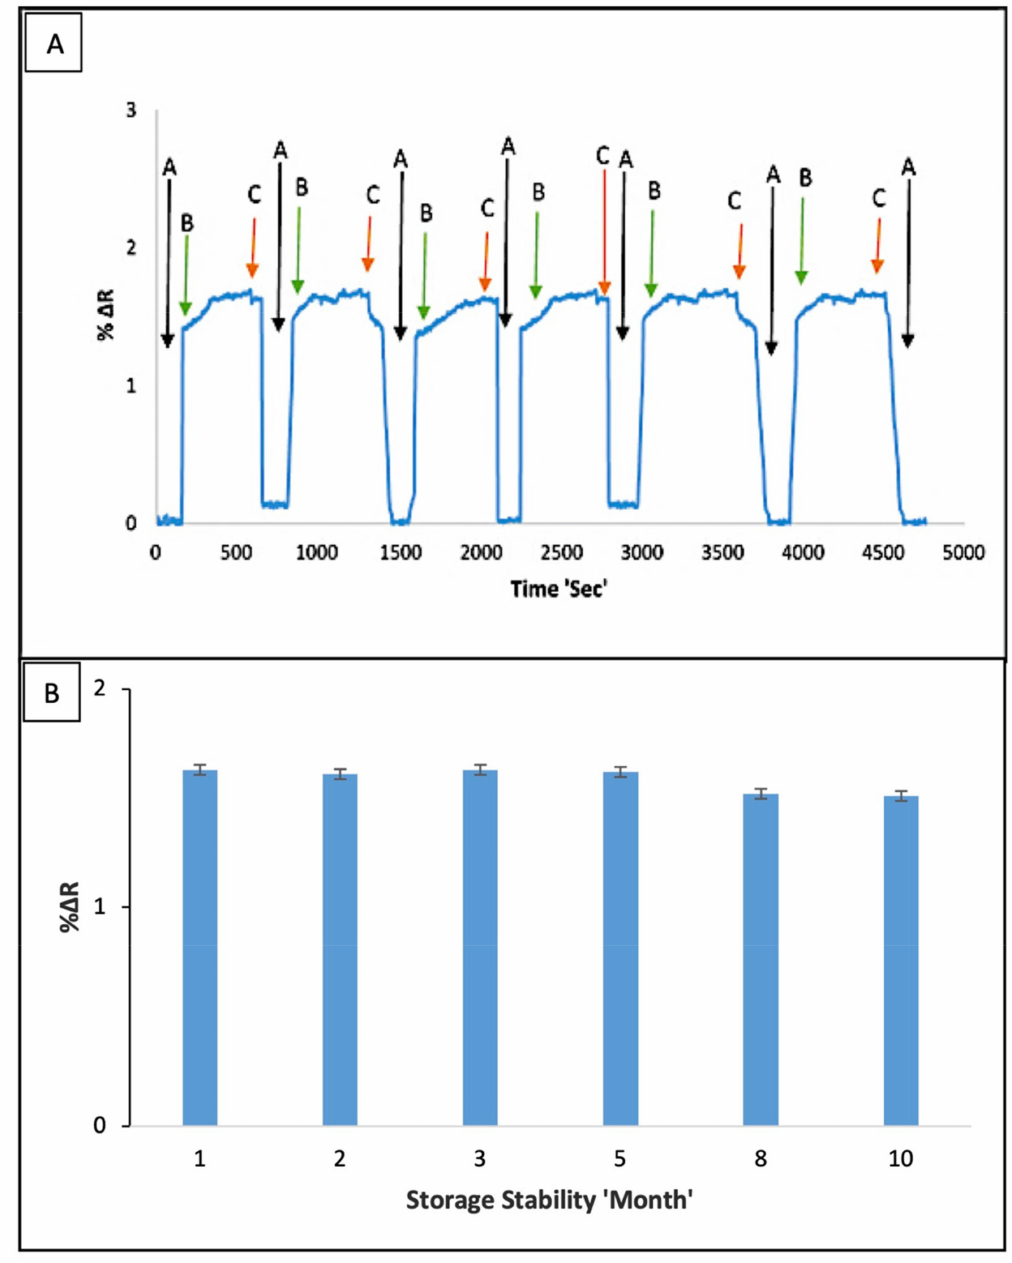
Figure 5. ( A ) The reusability of the I-SPR sensor (“A”: equilibration, “B”: binding, “C”: desorption), ( B ) The storage stability results of the I-SPR sensor in aqueous solution within 1–10 month periods (hIgM concentration: 5 ng/mL, pH: 7.4., flow rate: 150 µ L/min and T: 25 ◦